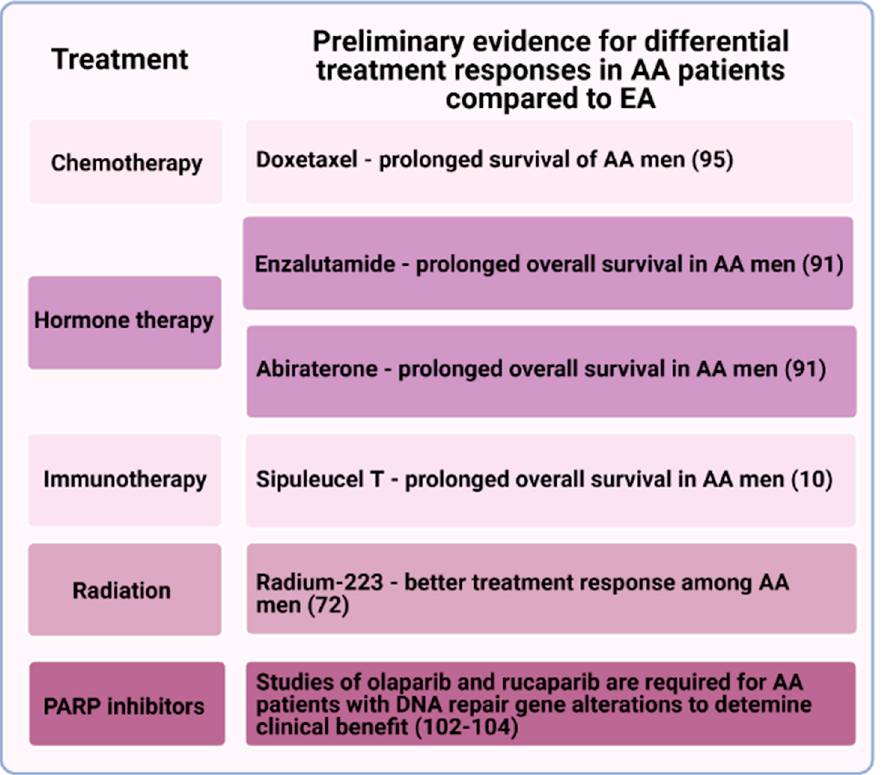
Figure 2. Preliminary evidence for certain treatment response differences between African American (AA) and European American (EA) patients with metastatic castration-resistant prostate cancer (mCRPC). Current approved treatment modalities for mCRPC, how clinical responses may differ between the two patient groups, and where additional studies are warranted. For PARP inhibitor use, the pathologic role of germline variants of unknown significance in DNA repair genes that commonly occur in AA men needs to be investigated.